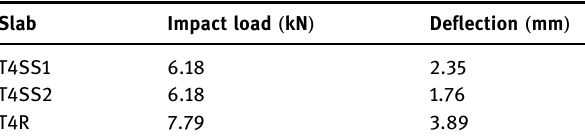
Table 3: Load - de fl ection results for impact test Slab